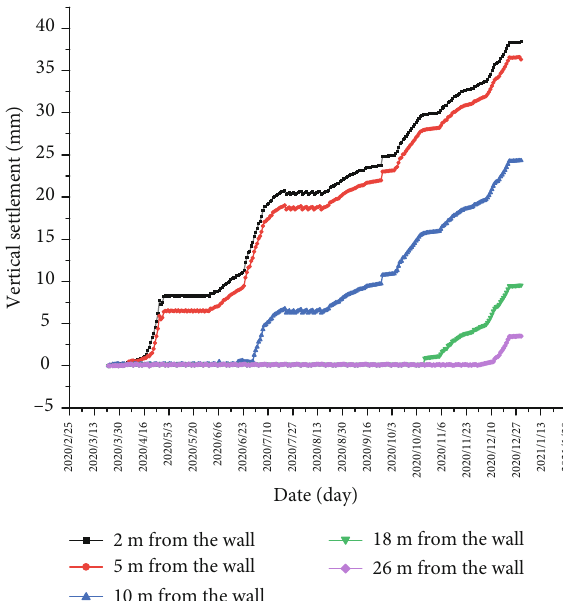
Figure 12: Vertical displacement curve of soil behind a typical section